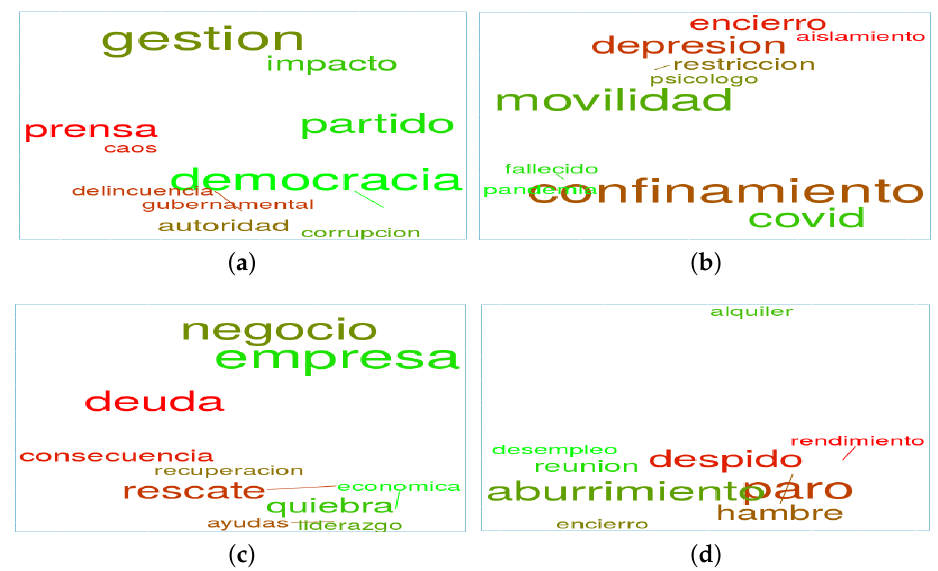
Figure 5. Relationships among words for different topics and countries. ( a ) government topic, in Spain; ( b ) health topic, in Peru; ( c ) economy topic, in Mexico; and ( d ) employment topic, in Chile.